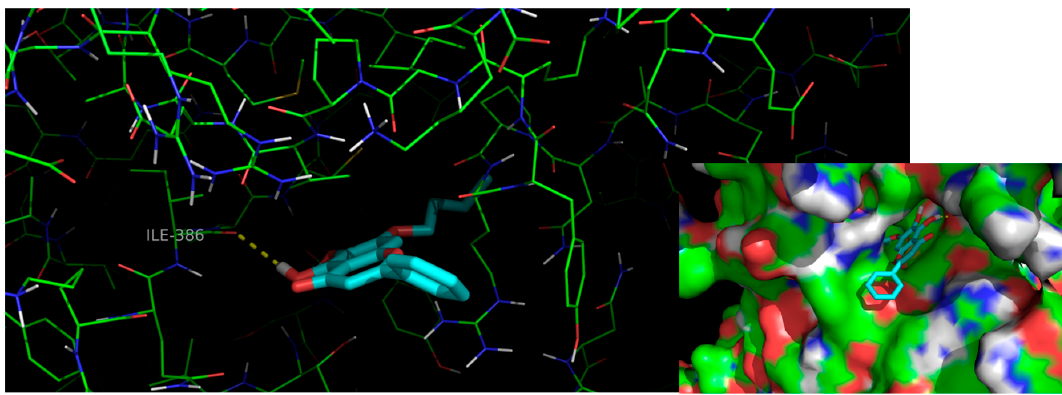
Figure 5. Interactions of flavone 13 (blue sticks) with residues in the allosteric site of procaspase-7. Polar interactions are represented as yellow broken lines. Carbon, oxygen, nitrogen and sulfur atoms of the target are represented in green, red, blue, and yellow, respectively.